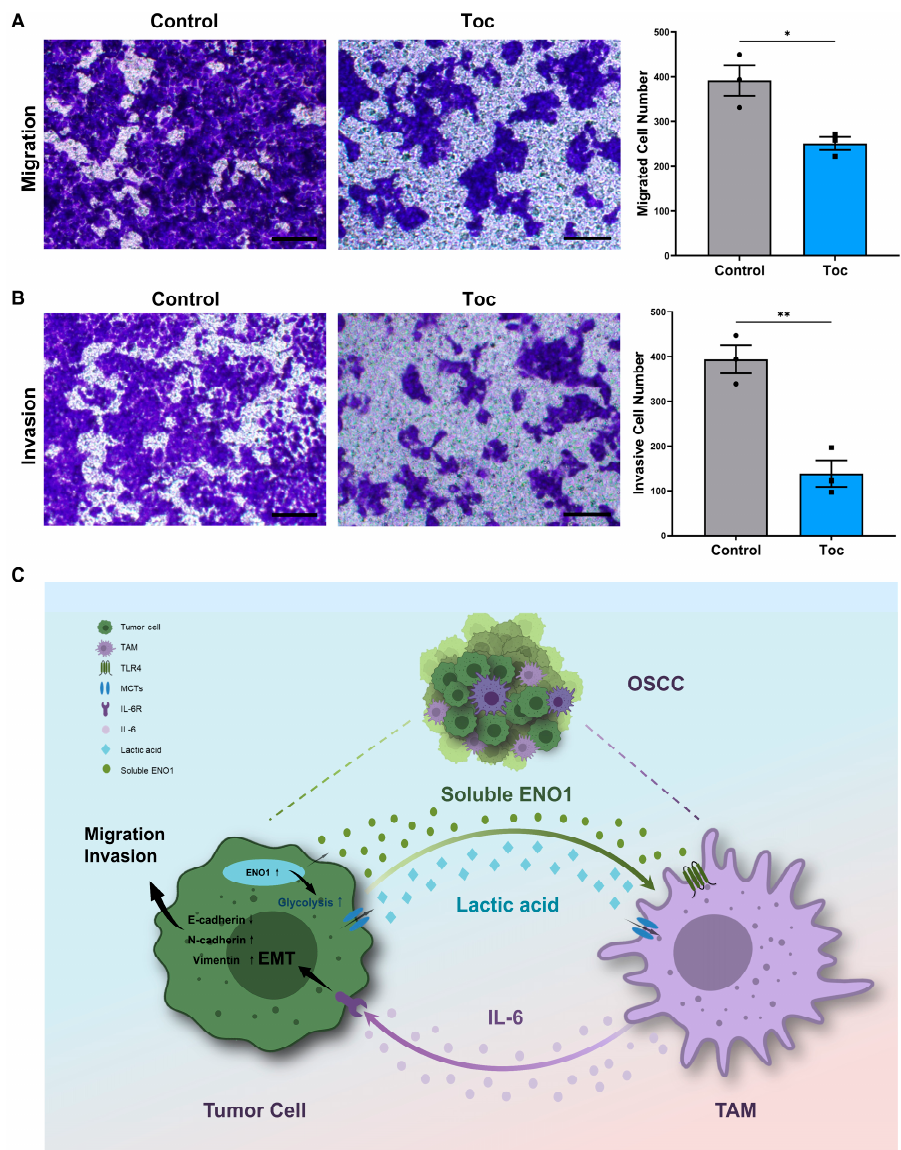
Figure 7. IL-6 promotes the migration and invasion of tumor cells. ( A ) Transwell assay for migration of CAL27 cells (upper chamber) pretreated without or with IL-6R antagonist tocilizumab (Toc, 5 µ g/mL) and cocultured with macrophages (lower chamber) for 24 h. Left panel, representative pictures; right panel, bar charts indicating the cell numbers of migrated cells per area. Magnification 200 × . Scale bar: 100 µ m. ( B ) Transwell assay for invasion of CAL27 cells (upper chamber) pre- treated without or with the IL-6R antagonist tocilizumab (Toc, 5 μ g/mL) and cocultured with mac- rophages (lower chamber) for 48 h. Left panel, representative pictures; right panel, bar charts indi- cating the cell numbers of invasive cells per area. Magnification 200×. Scale bar: 100 μ m. ( C ) Graphical abstract. ENO1 promotes tumor cell migration, invasion and EMT by orchestrating mac- rophage-derived IL-6 via secretion of lactic acid and extracellular ENO1 in OSCC, thus forming a positive feedback loop to promote OSCC progression. Different symbols (circle/square/triangle) were used to represent the data points of independent biological repeated experiments. All data are displayed as mean ± SEM; n = 3; * p < 0.05 and ** p < 0.01. 3. Discussion In the present study, we demonstrated that ENO1 was highly expressed in OSCC cells and was crucial for maintaining pro-tumoral properties via orchestrating the